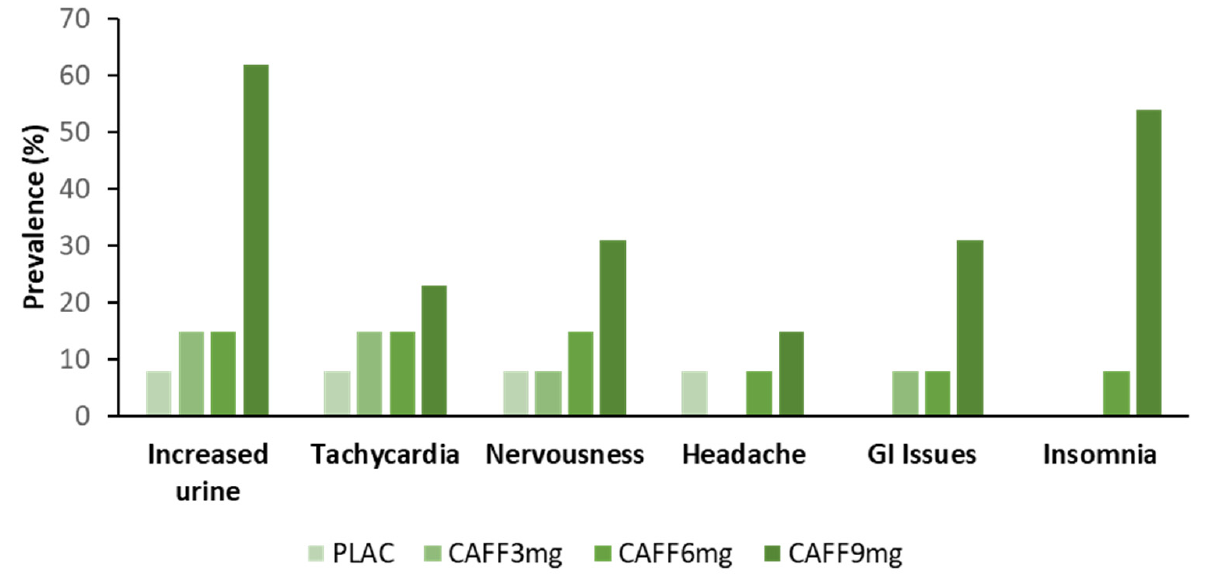
Figure 1. Percentage of participants reporting side effects to increasing caffeine dose following a neuromuscular test battery. Adapted from Pallarés et al. [25]. [PLAC = placebo; CAFF = caffeine; GI = Gastrointestinal; results based on data from N = 13 resistance-trained men].